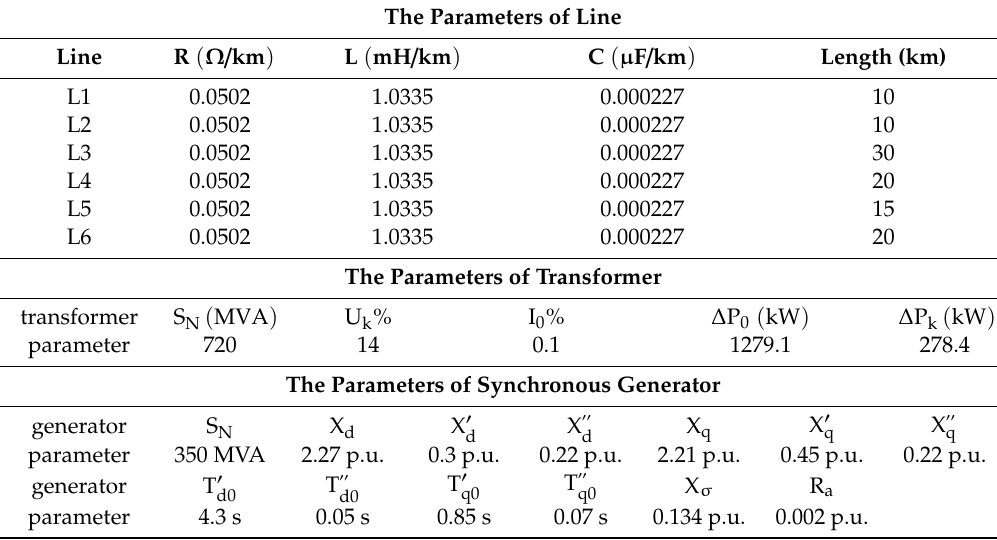
Table 2. The parameters of the equipment in the AC